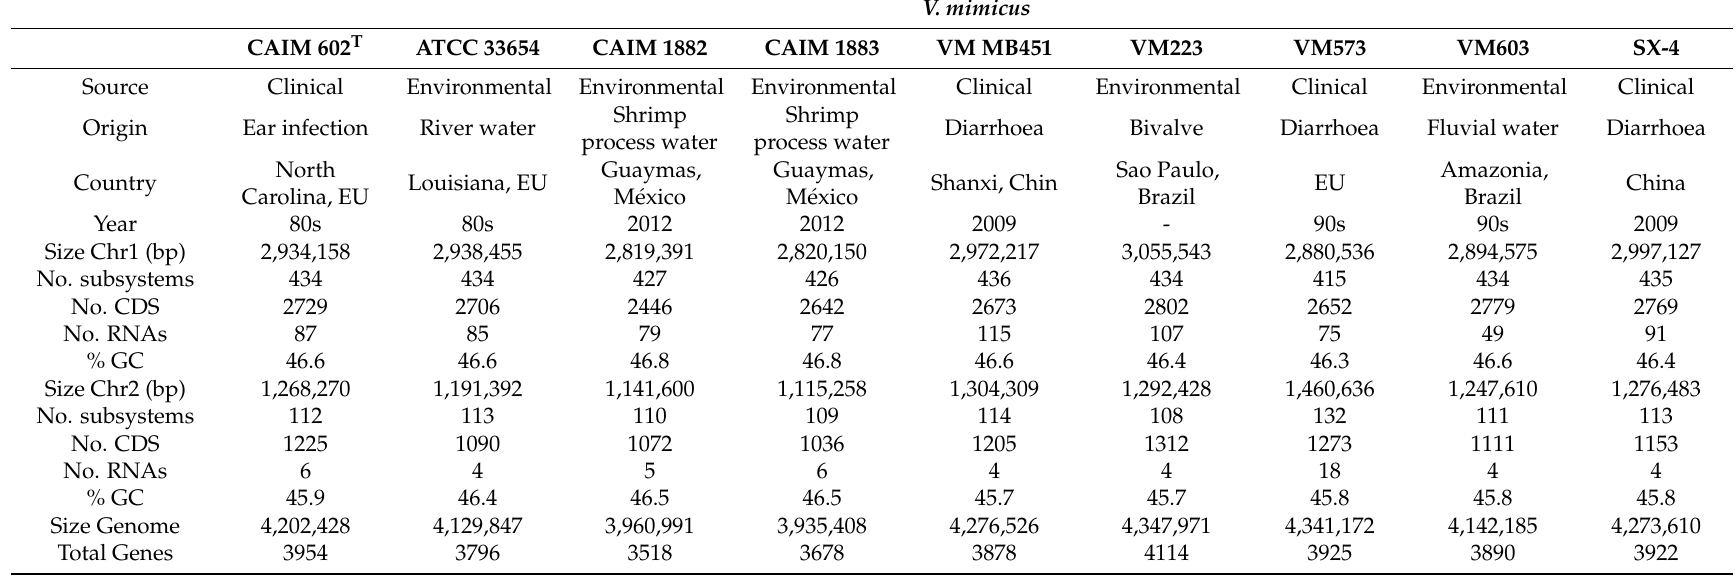
Table 1. General characteristics of the nine genomes of V. mimicus included in this